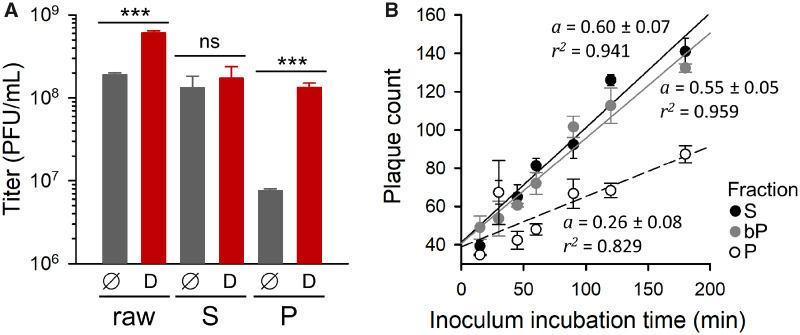
Potential fitness costs of membrane-associated viral shedding. (A) Effect of Triton X-100 treatment on the titer of raw infection media, S and P fractions for the WT founder (D: detergent; ∅: untreated controls). Error bars correspond to the SEM (n = 3 replicates). Asterisks indicate the statistical significance of a log-scale t-test against the founder (ns, nonsignificant; ***P < 0.001). (B) Increase in the number of PFUs as a function of inoculum incubation time in standard plaque assays using S-fraction, P-fraction, and bP inocula. Regression lines are shown (a: slope; r2: coefficient of determination). Error bars correspond to the SEM (n = 3 replicates).